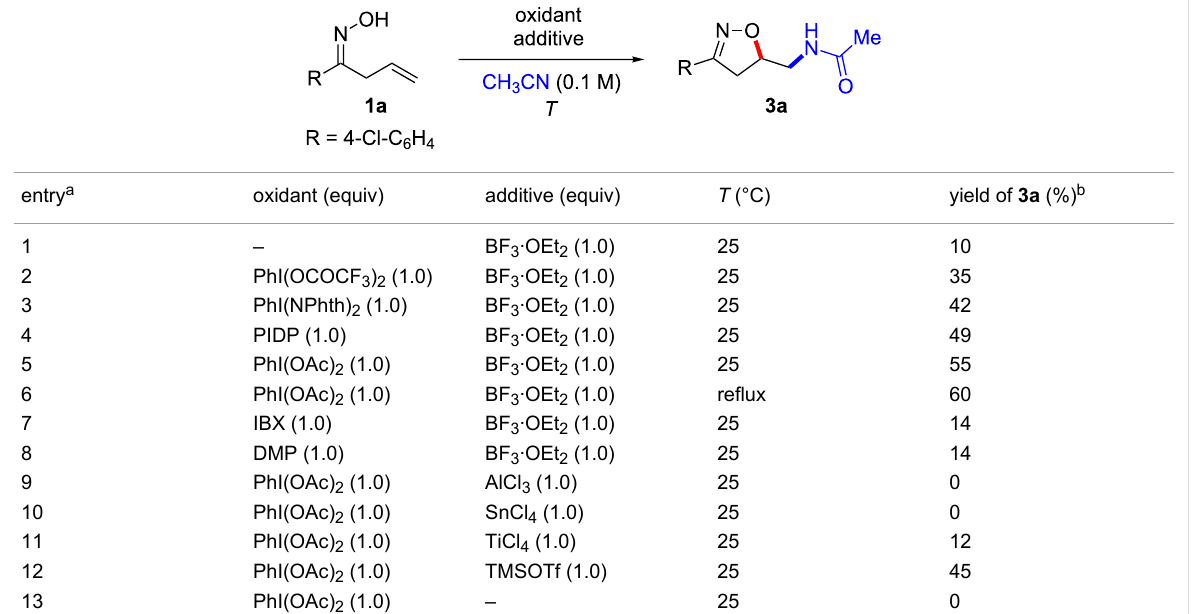
Table 1: Hypervalent iodine-mediated Ritter-type alkene